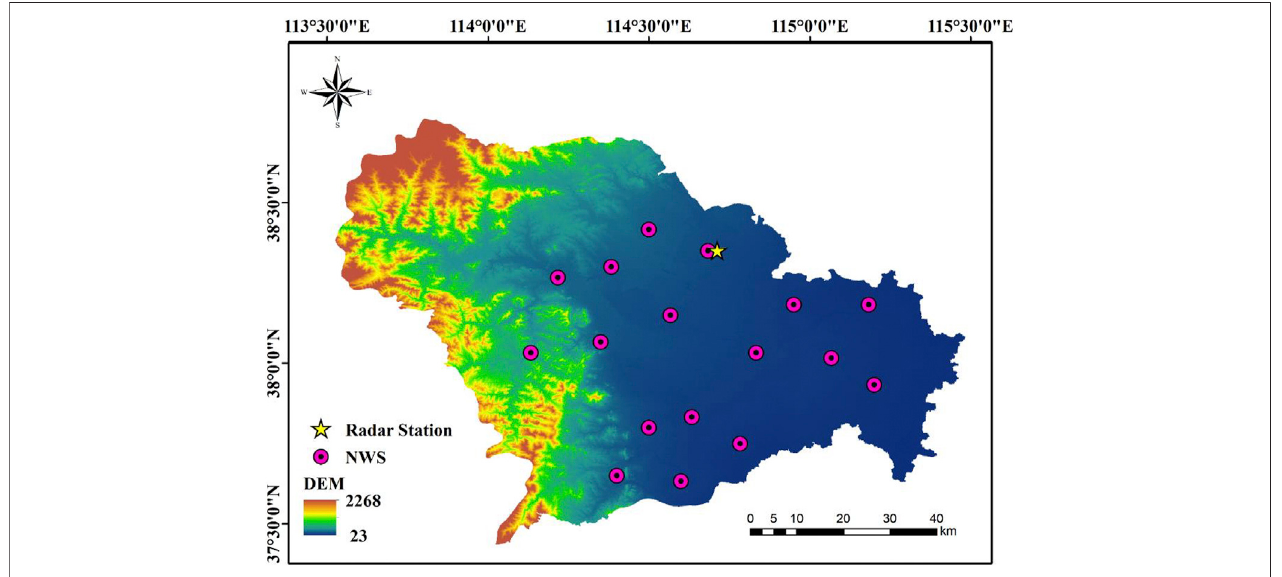
FIGURE1| ElevationmapofShijiazhuangcity.Themapshowsthedistributionofradarstations(yellowpentagons)and17NWSs(pinkcircles)andtheextentofour study area.